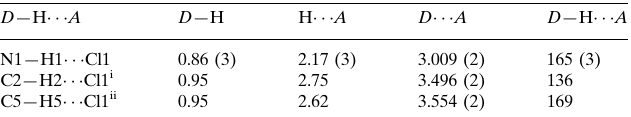
Hydrogen-bond geometry (A˚ , (cid:3)